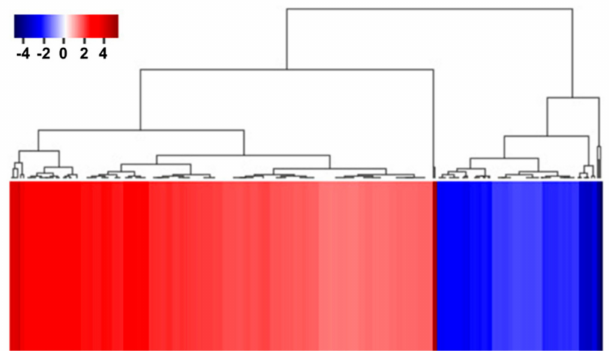
Figure 4. Hierarchical clustering of up- and downregulated genes in AtRH17 OXs. Hierarchical clustering of up- and downregulated genes were performed using MultiExperiment Viewer